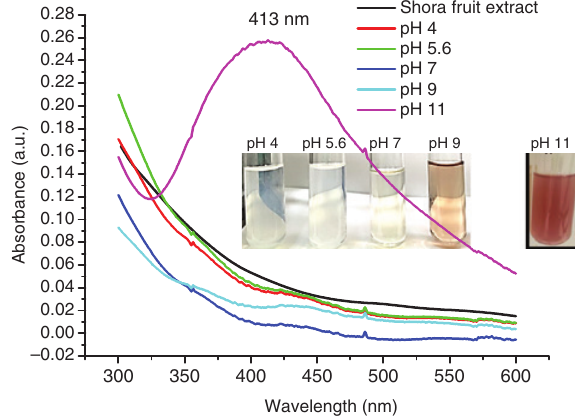
Figure 2: Visual and UV-vis spectrum of Shora fruit mediated silver nanoparticles (AgNps) at different pH.